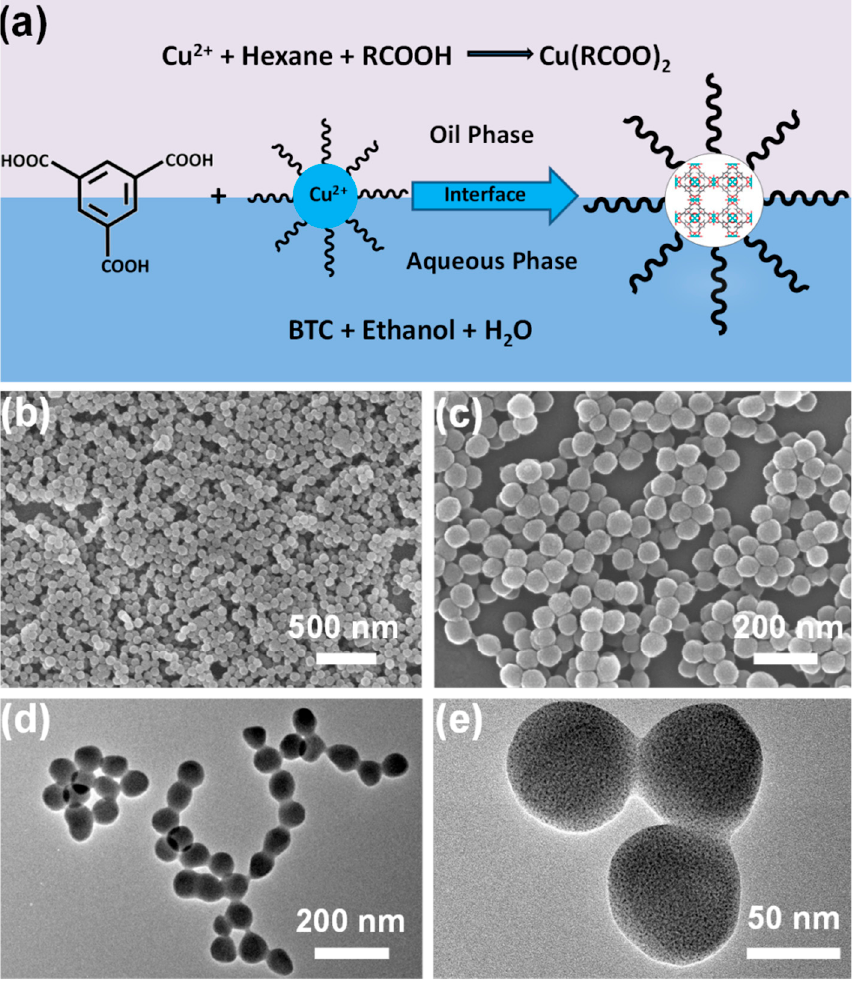
Figure 2. ( a ) Schematic illustration of formation mechanism of nanosized HKUST–1. Representative SEM ( b , c ) and TEM ( d , e ) images of nano HKUST–1 with different magnifications. Reproduced from Ref. [77] with permission from the American Chemical Society, copyright 2019.